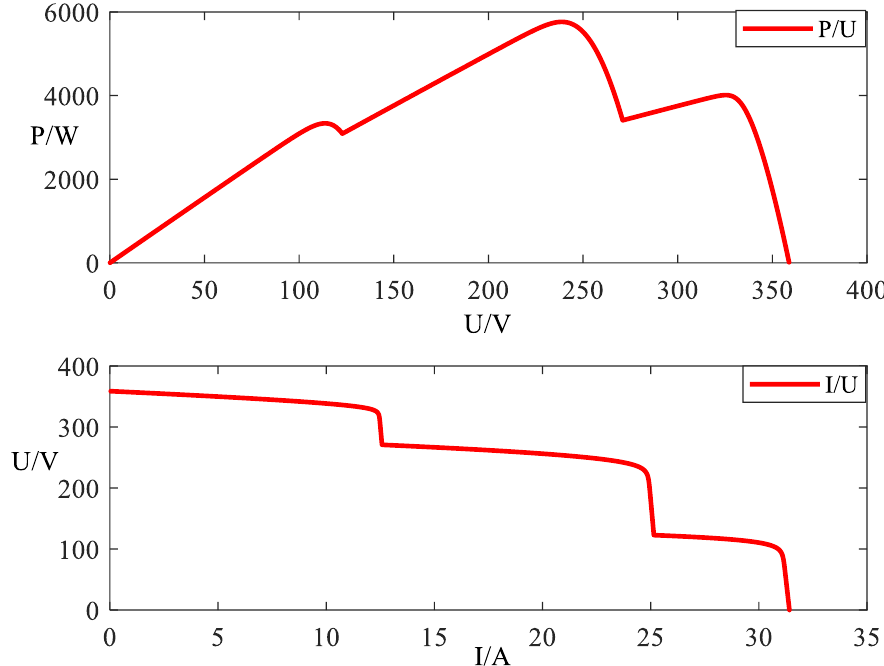
Figure 3. Output characteristics curve of PV power generation under uneven radiance.